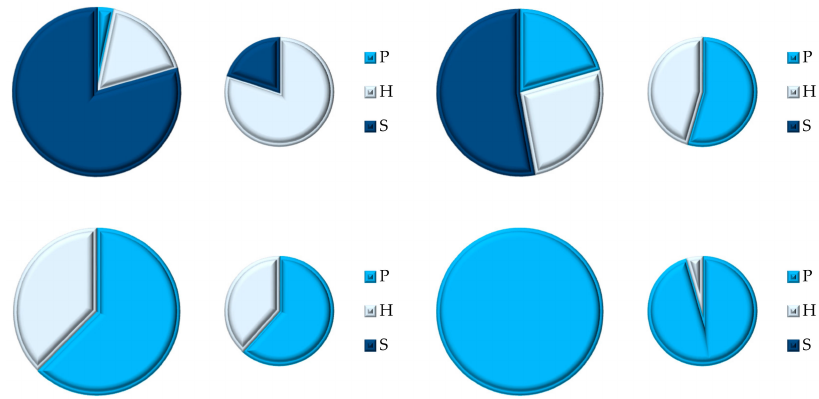
Figure 3. The first stand storey (larger circles) and undergrowth (smaller circles) distribution by species in four study plots of 0.5 ha each. The letters of legend indicate: P—pedunculate oak, H—hybrid oak, S—sessile oak.